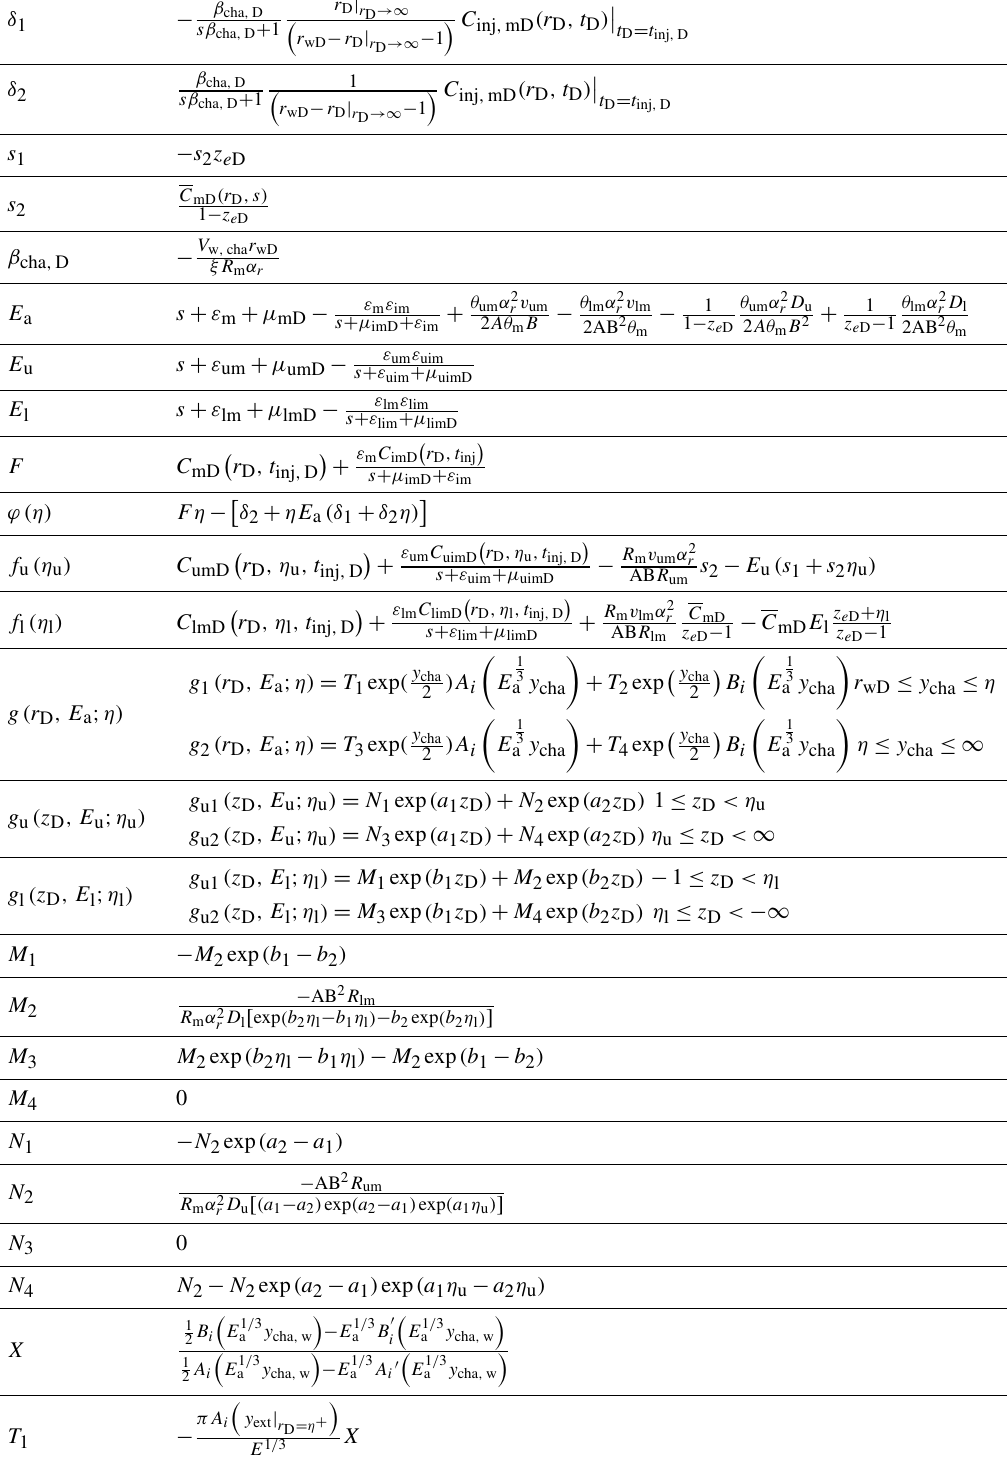
Table 2. Expressions of the coefficients in the solutions expressed in Eq. (26a)–(26g). δ